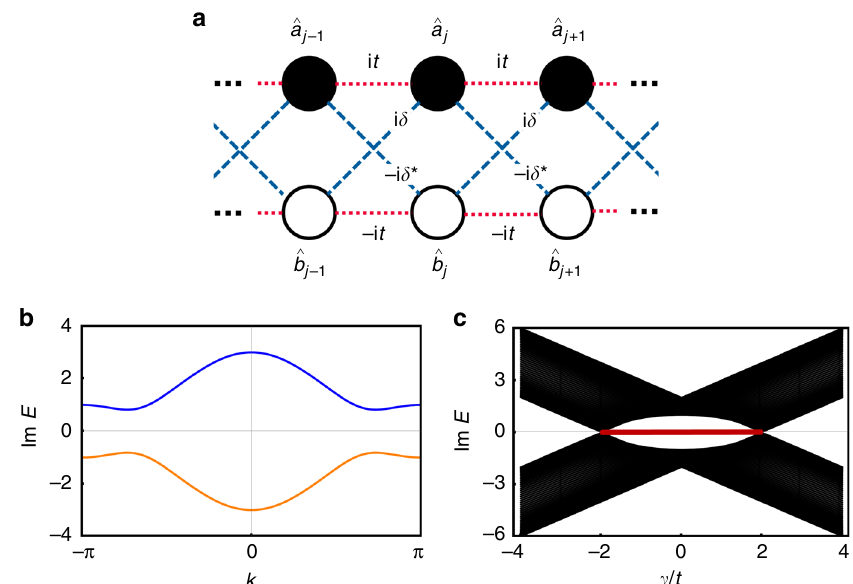
Fig. 3 Non-Hermitian one-dimensional topological insulator with time-reversal symmetry. The results shown are for the 1D class AI model described by Eq. (3). a Schematic representation of the Hamiltonian. The system consists of the asymmetric hopping and the gain/loss. b Energy dispersion of the chain with periodic boundaries ( t = 1.0, δ = 0.5, γ = 1.0). The imaginary spectrum is gapped for | γ | ≠ 2 t . c Imaginary spectrum of the system of L = 50 sites with open boundaries ( t = 1.0, δ = 0.5). Edge states with I mE = 0 (red line) emerge in the topological phase (| γ / t | ≤